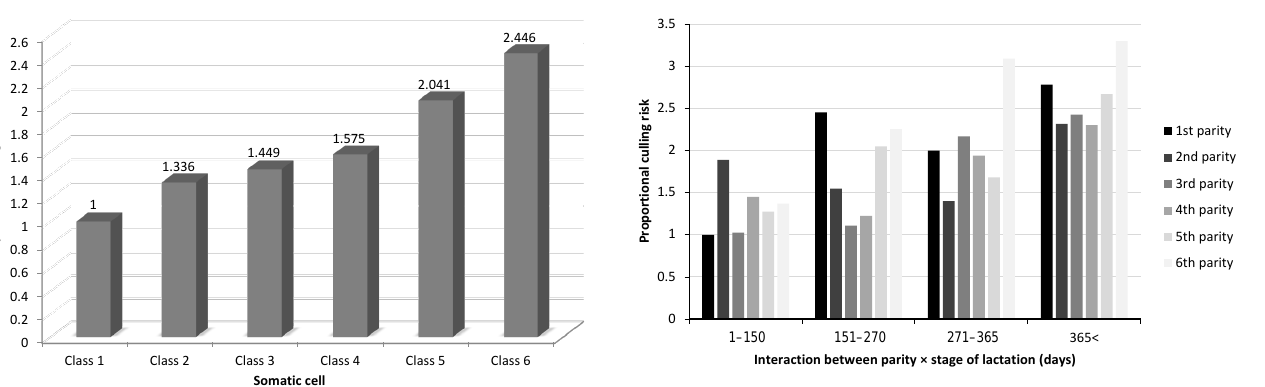
Figure 1. The relationship between somatic cell and proportional culling risk.